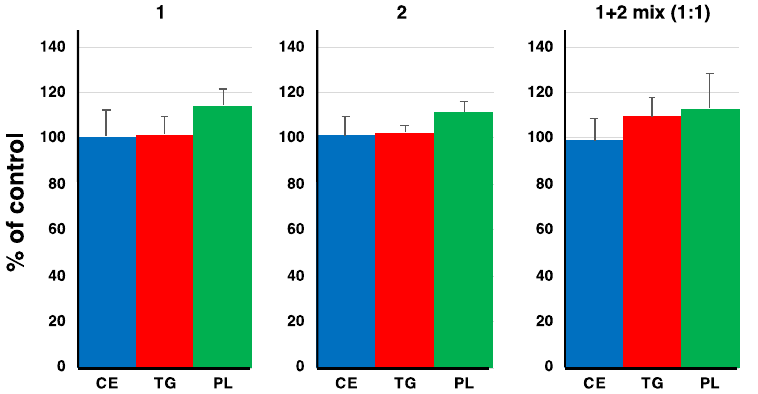
Figure 6. Effects of 1 and 2 on the synthesis of [ 14 C]TG, [ 14 C]CE and [ 14 C]PL (phosopholipid) from [ 14 C]oleic acid in CHO-K1 cells. Compounds were treated at 14.5 µ M. Error bars ± s.d. ( n = 3).